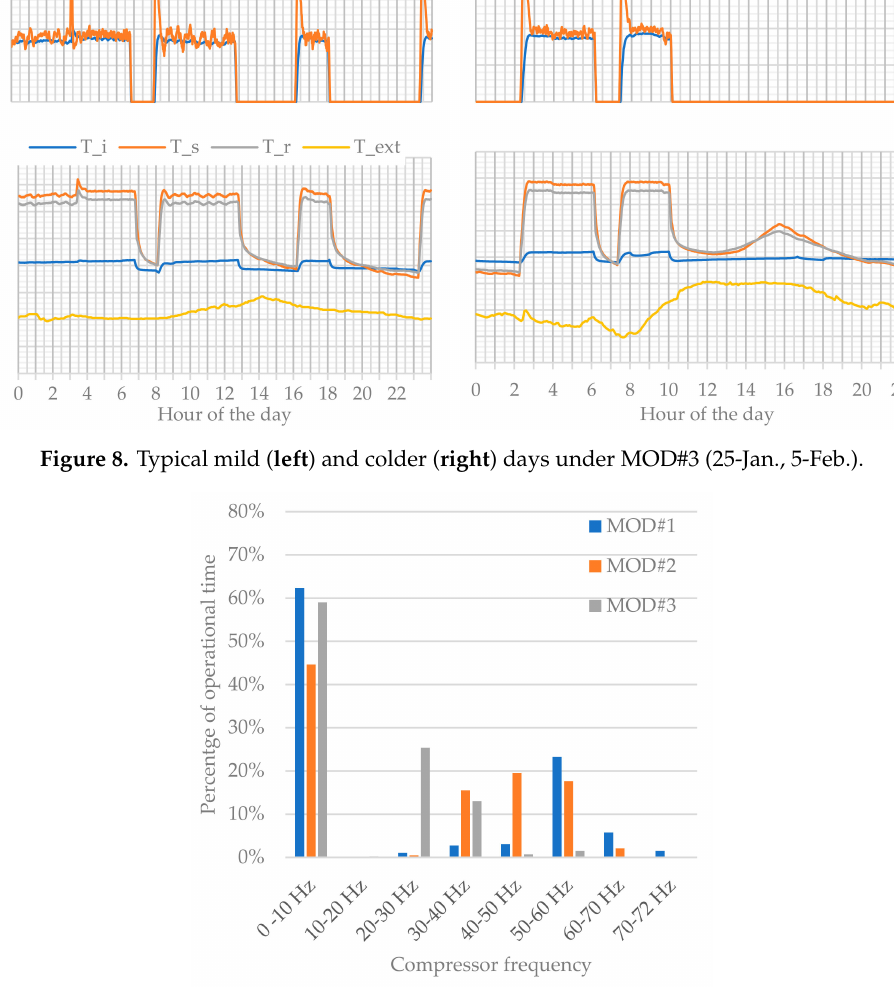
Figure 9. Compressor frequency distribution as percentage of time under each operational mode.